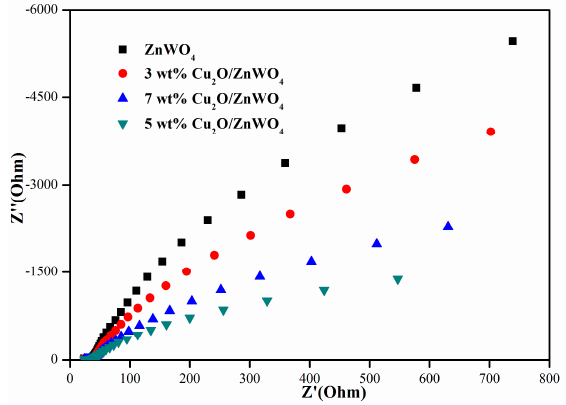
Figure 7. Electrochemical Impedance Spectra (EIS) plots of pure ZnWO 4 and as-prepared various Cu 2 O/ZnWO 4 samples irradiated with visible light.